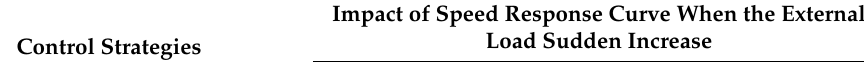
Figure 4. ( a ) Speed response curves without load; ( b ) Detailed view of the image ( a ); ( c ) Detail of the beginning of the image ( a ). Table 5. The comparative results of the load changed